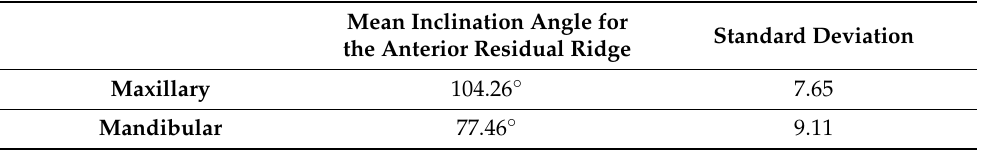
Table 4. The mean inclination angle of the anterior residual ridges with the mean correction angles and standard